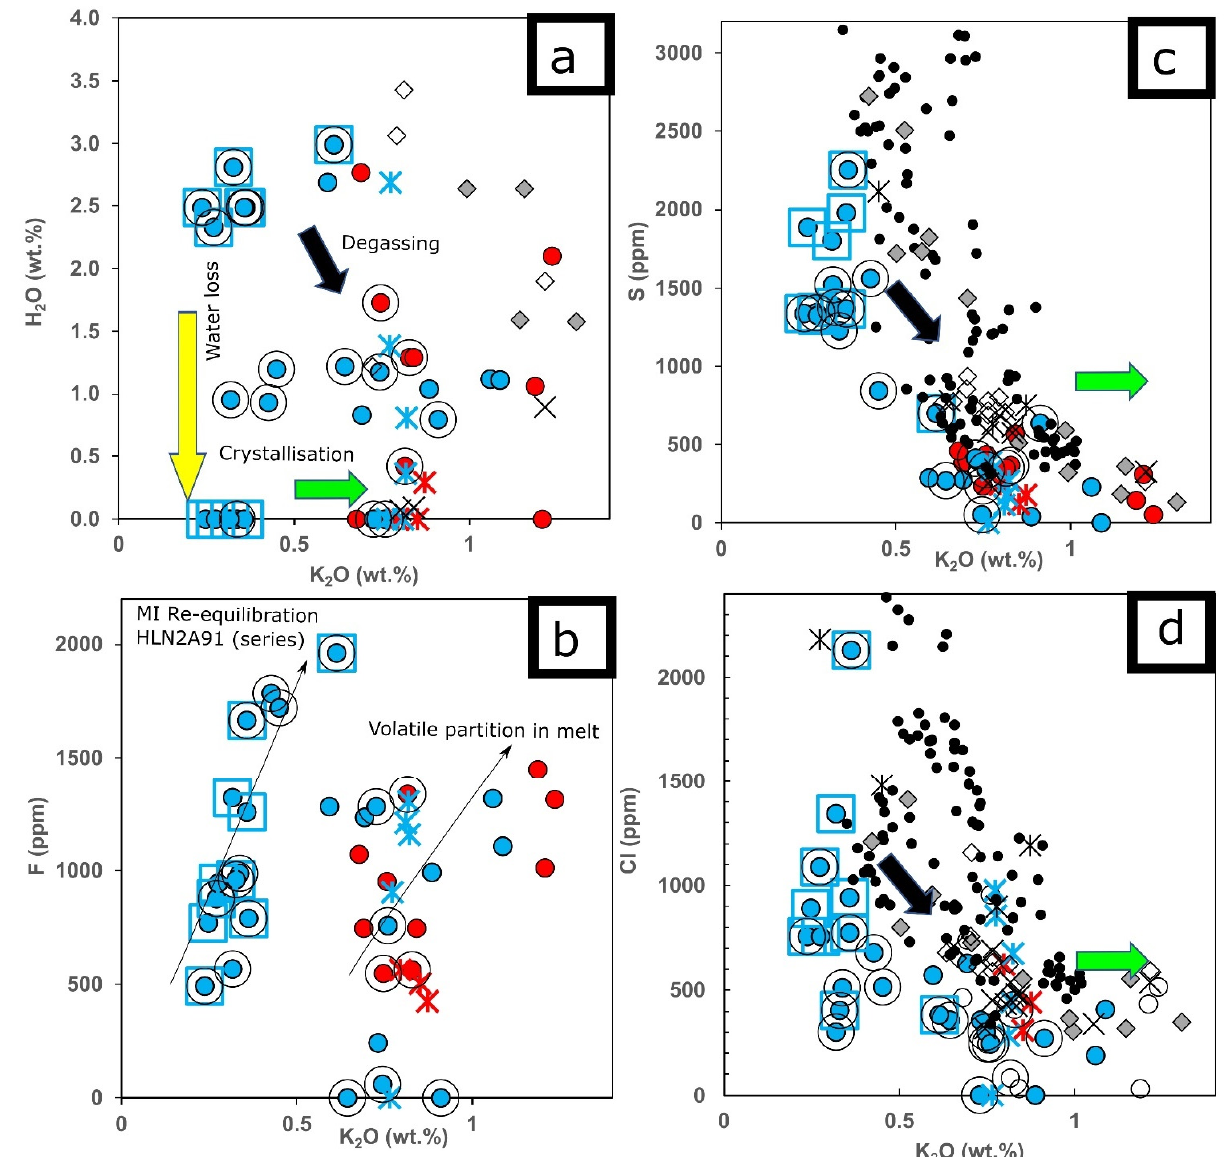
Figure 6. Variation of volatile contents in LNG2 samples. ( a ) H 2 O versus K 2 O, ( b ) S versus K 2 O, ( c ) Cl versus K 2 O, and ( d ) F versus K 2 O. Green arrow represents “crystallization”, yellow arrow “water loss” (H 2 O) and black arrow “degassing”. Symbology is the same as previous figures. CVS stands for central volcanic zone and represent inclusions from [49].